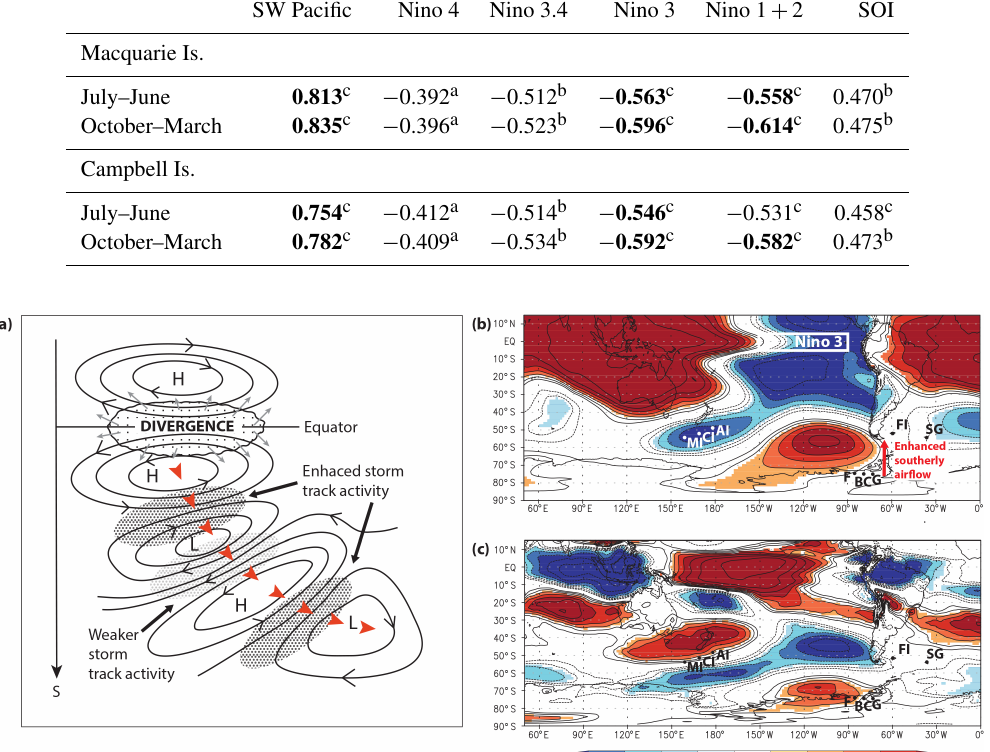
Figure 6. Rossby wave propagation from the tropical Pacific during the austral spring–summer. Low-to-high-latitude atmospheric telecon- nections during the austral spring and summer (October–March). Schematic showing extratropical Pacific–South America (PSA) Rossby wave train (red arrows) associated with low- and high-pressure systems generated by anomalous equatorial upper-level divergence flow (Trenberth et al., 1998); enhanced southerly airflow across the West Antarctic coastline extends into the South Atlantic during anomalously high temperatures in the Nino 3 region (a) . Spatial correlations between detrended and deseasonalised Nino 3 sea surface temperature (Rayner et al., 2003) (October–March) and 850hPa height (b) and zonal wind stress (c) using ERA-Interim (Dee et al., 2011) for the period 1979–2015. Location of key sites are shown. Significance p field < 0 .